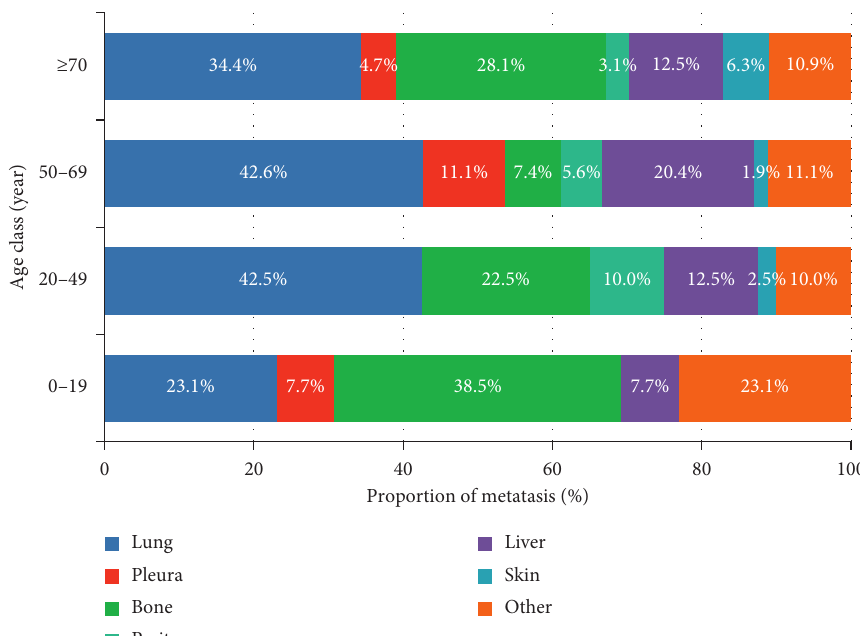
Figure 3: Most important metastasis sites according to age for soft tissue sarcomas diagnosed in 2009–2012 in 15 Italian population-based cancer registries.